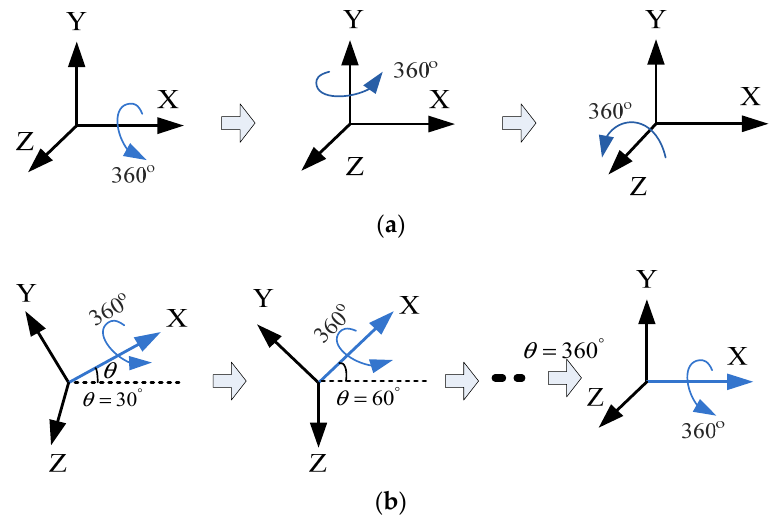
Figure 3. Calibration attitude changes. ( a ) Attitude change 1; ( b ) Attitude change 2.